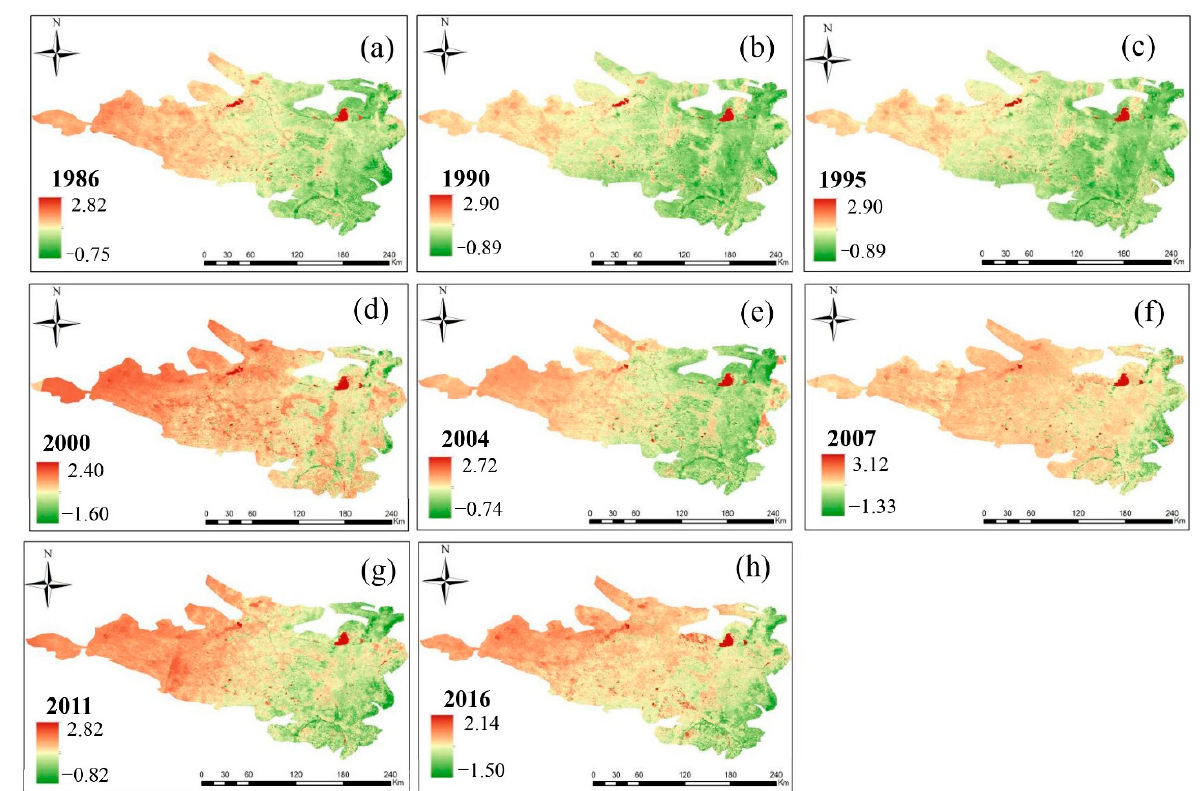
Figure 3. Spatial ‐ temporal distribution of desertification index in OSL from 1986 to 2016.